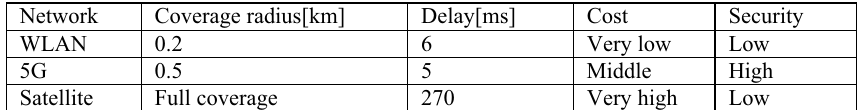
Table 5. Simulation